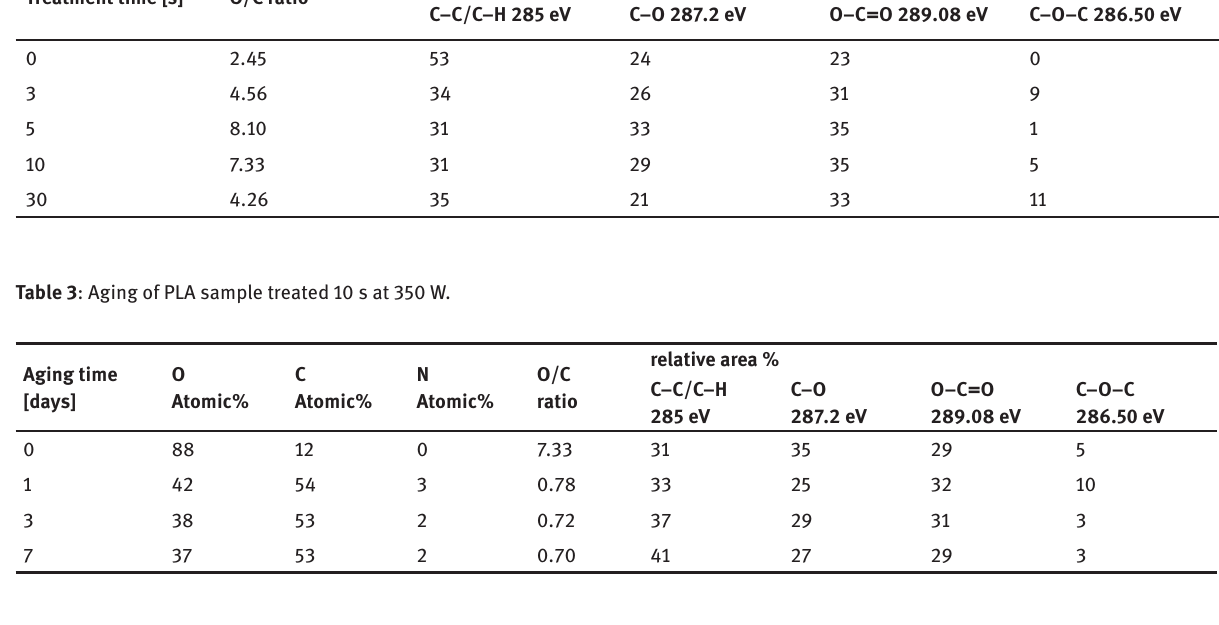
Treatment time [s]